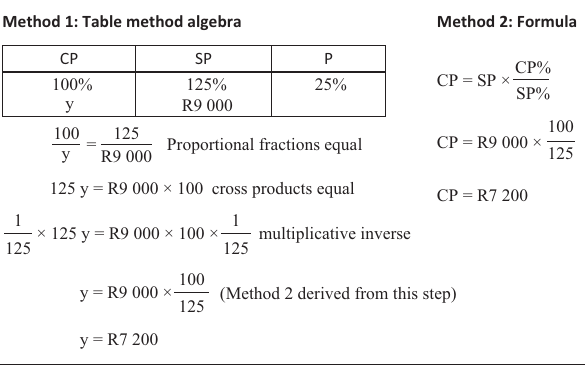
FIGURE 10: Cost price